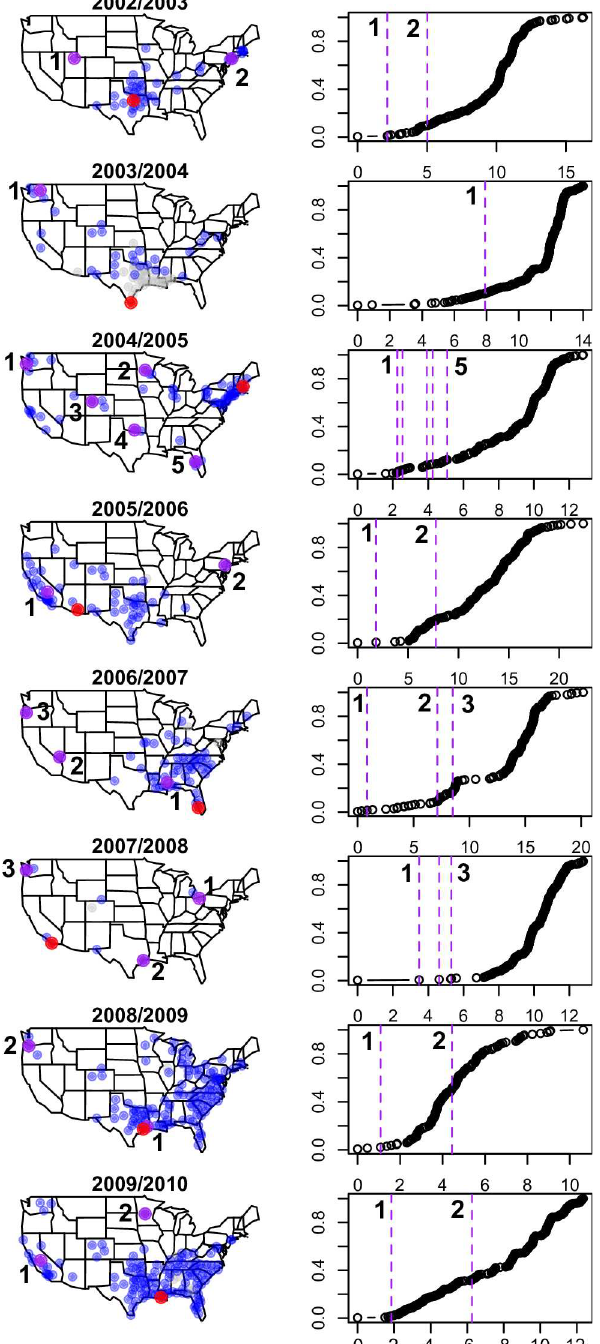
Fig 5. Long range transmission events and potential origins of each epidemic. For each season, the purplecircles indicate long-range transmission events (i.e. locationsfar from the set of infectiouslocations that obtain influenzaregardless). Blue circles are locationsinfected within a two-week windowfrom the last long-range event. Red circles depict the potentialoutbreak origin in each epidemic. Grey circles are infected locationsbefore the first long-range event occurredin each season. Panels on the right indicate when in the epidemic long-range events occurred. Note that the methods used to identify long-range transmission events and estimate the origin of each epidemic are agnosticof one another; in 2008/2009 an early “long-range transmission event” appearsnear the estimated origin of the epidemic.